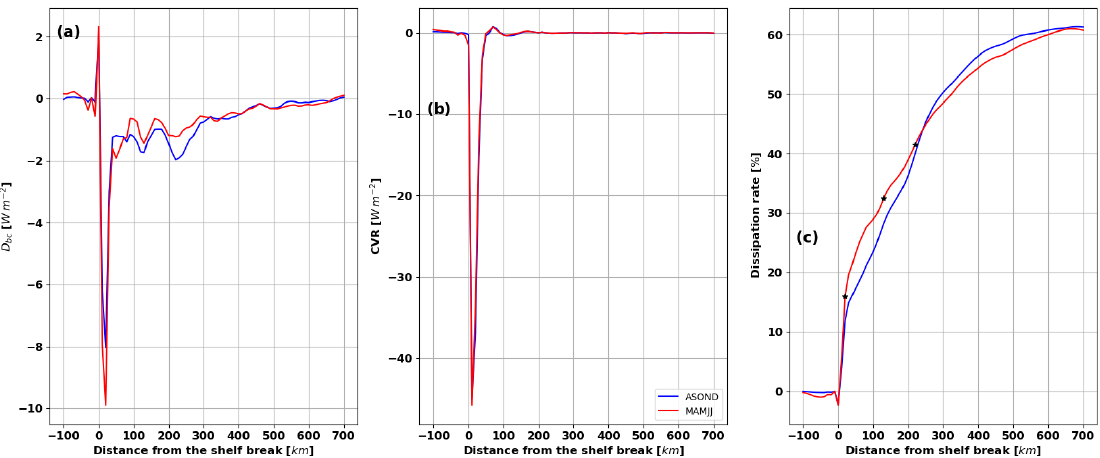
Figure 8. (a) D bc (units: Wm − 2 ), (b) CVR (units: Wm − 2 ), and (c) dissipation rate (%) as a function of distance from the continental shelf break. CVR and D bc are integrated every 10km from the shelf break. The dissipation rate is the ratio between the cumulative sum of D bc and the sum of CVR within the first 50km from the shelf break. ASOND is in blue and MAMJJ is in red. The black stars are the locations of the three peaks of maximum